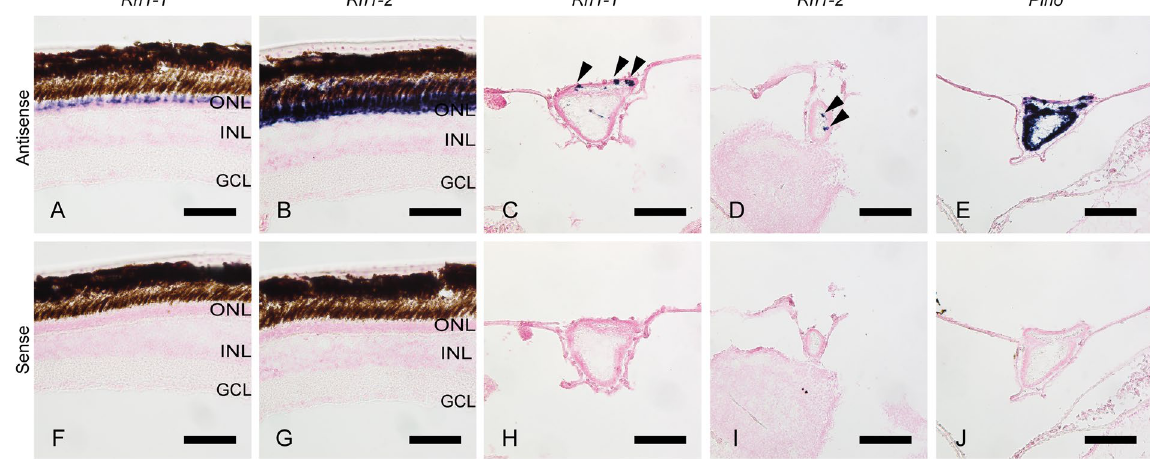
Figure 5. Distribution of rhodopsin in the retina and the pineal gland of spotted gar. In situ hybridization of two rhodopsins ( Rh1-1 and Rh1-2 ) and pinopsin ( Pino ) in the retina and the pineal gland of spotted gar. The sections of the retina were hybridized with antisense probes of Rh1-1 ( A ) and Rh1-2 ( B ), respectively. The frontal sections of the pineal gland were hybridized with antisense probes of Rh1-1 ( C ), Rh1-2 ( D ), and Pino ( E ), respectively. Allow heads indicate the positions of hybridization signals of Rh1-1 in ( C ) and Rh1-2 in ( D ), respectively. ( F–J ) show the consecutive tissue sections to ( A – E ) hybridized with corresponding sense probes, respectively. All the sections shown in this figure were counterstained with Nuclear Fast Red. Scale bar: ( A , B , F , G ) 50 μ m; ( C – E , H – J ) 100 μ m. ONL, outer nuclear layer; INL, inner nuclear layer; GCL, ganglion cell layer.